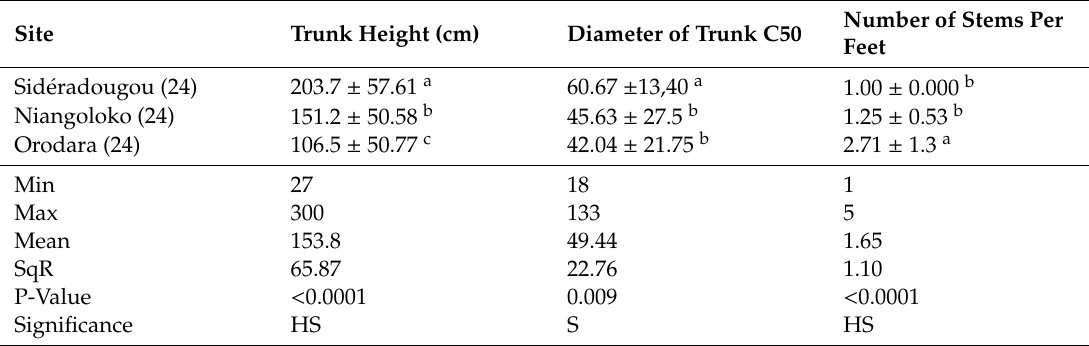
Table 4. Tree parameters.